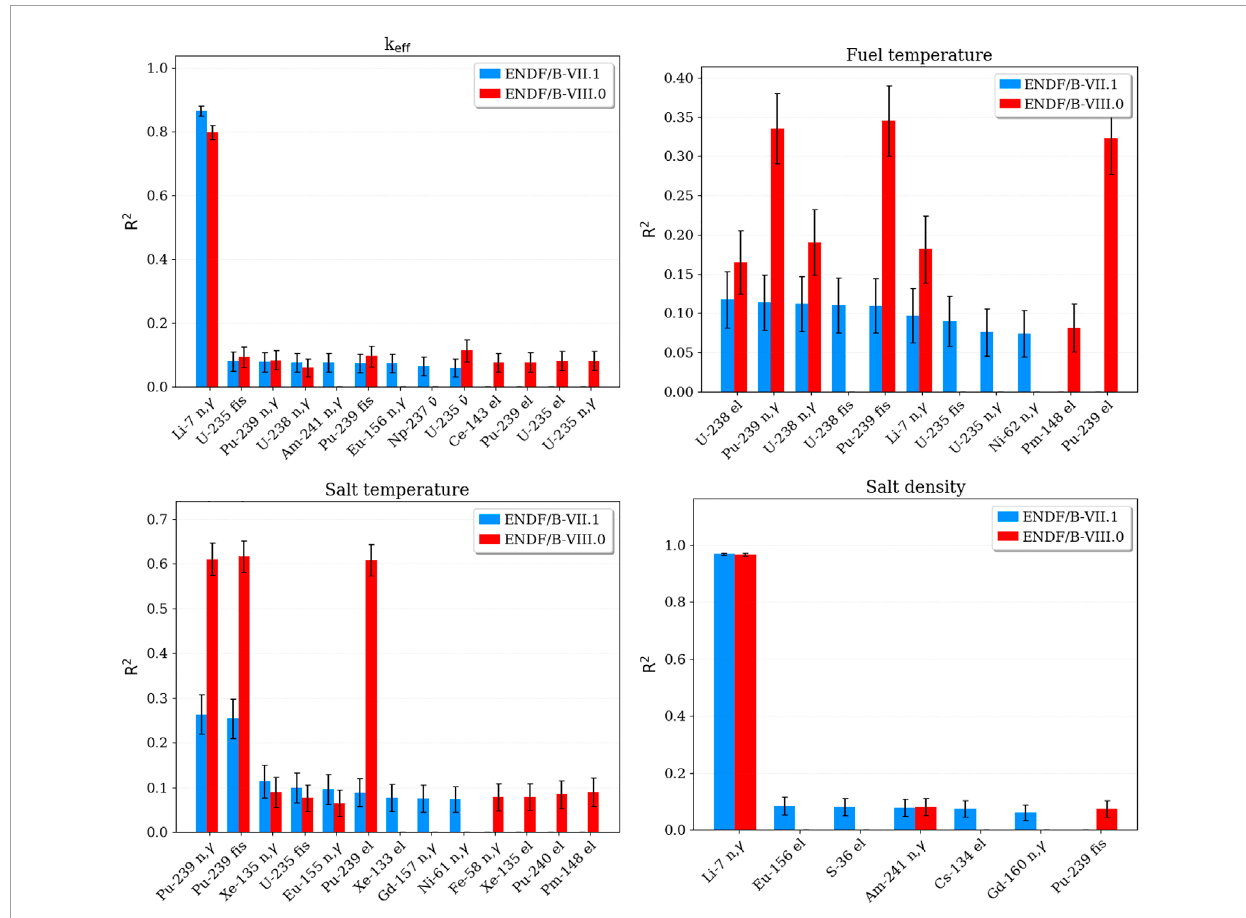
FIGURE 5 Top contributor to the output uncertainties of the UCB PB-FHR in terms of R 2 (as obtained with Sampler, accompanied by 95% confidence intervals).